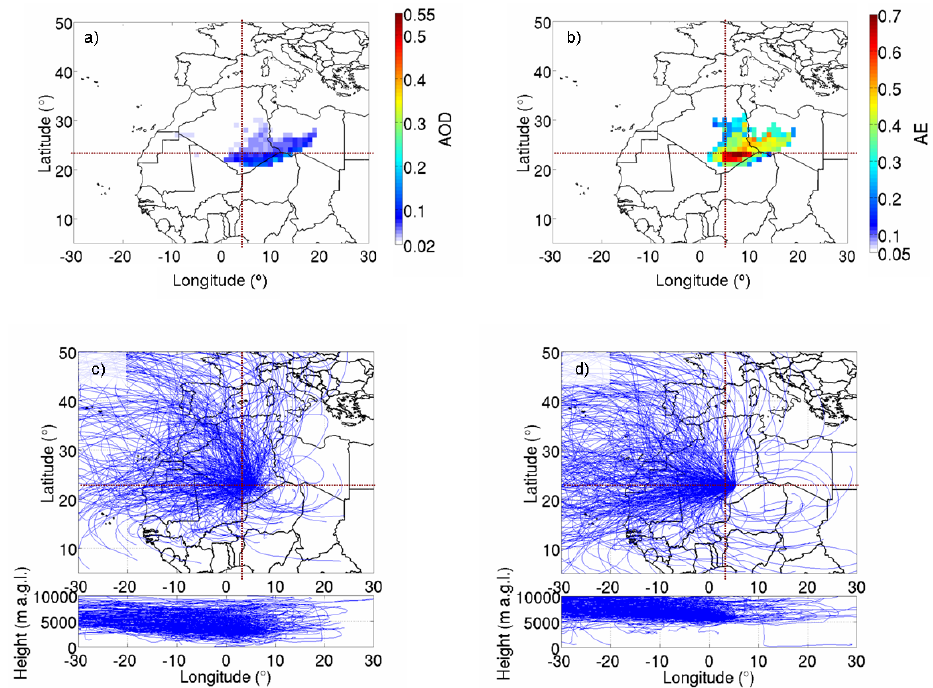
Figure 9. CWT maps at ground level for (a) AOD and (b) AE, and HYSPLIT back trajectories ending at (c) 2600 and (d) 5600ma.g.l. during the dry season (from November to February). Refer to dimensionless white/red scales for colour description of AOD and AE. Tamanrasset is located at the intersection of the four